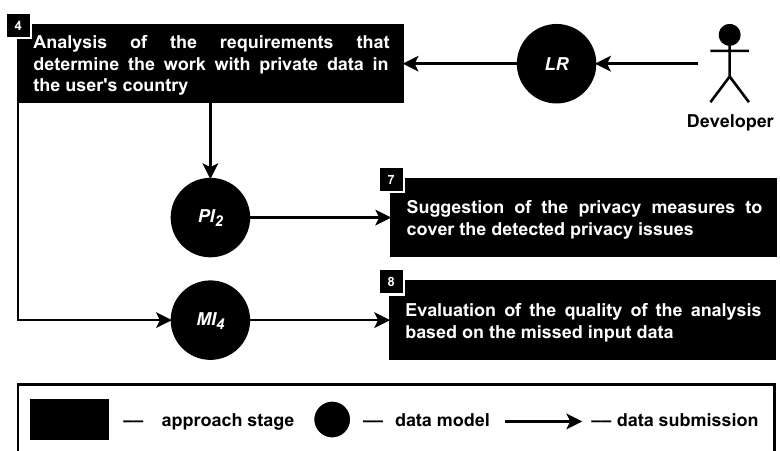
Figure 7. Stage 4—Analysis of the requirement to work with the user’s